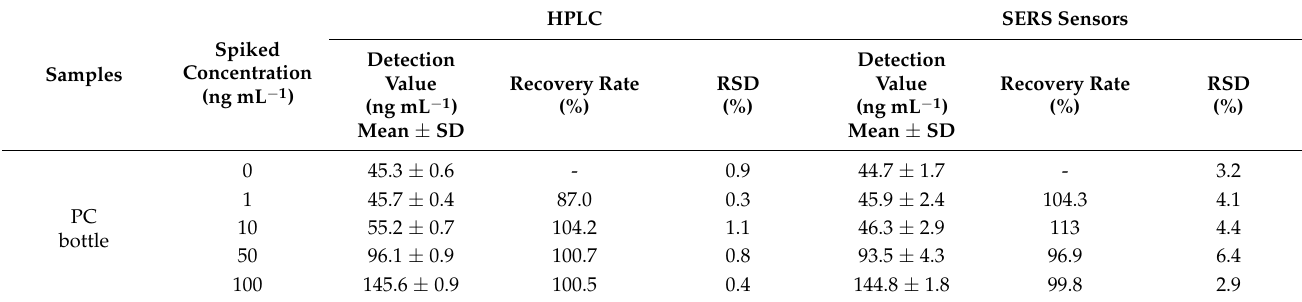
Table 1. Detection of BPA in spiked samples ( n = 5).